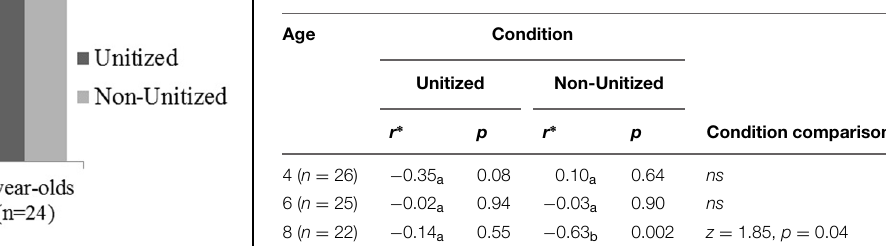
TABLE 2 | Partial correlation of global executive function and condition, controlling for